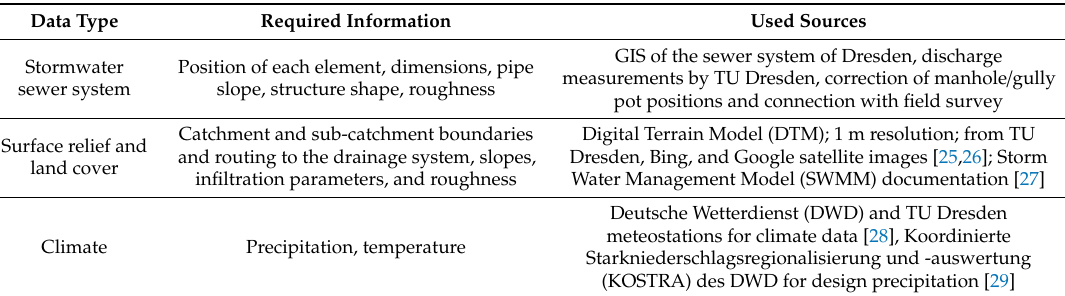
Figure 2. Study area (Pseudo-Mercator projection; OpenStreetMap are used as background [25]. Table 1 presents the required data for the modeling in the SWMM and the used sources. Table 1. Data requirements and sources.